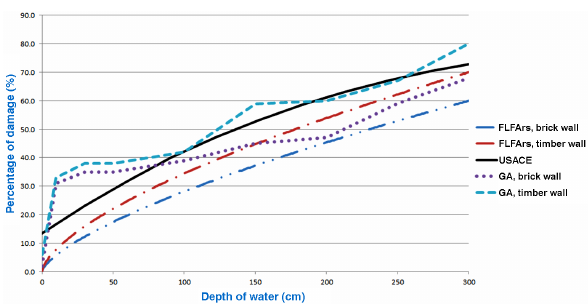
Figure 12. Model comparison for one-storey buildings (the FLFA rs has been derived by the most-likely functional parameters).